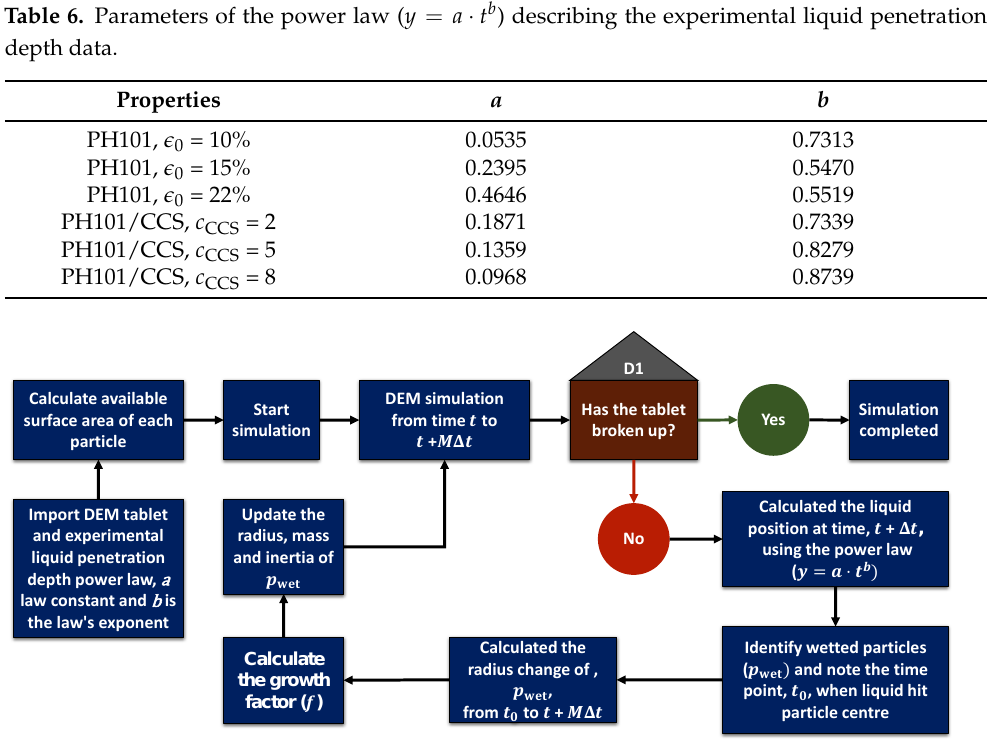
Figure 3. Flow chart for simulating tablet swelling using DEM incorporating a single-particle swelling model and experimental liquid penetration